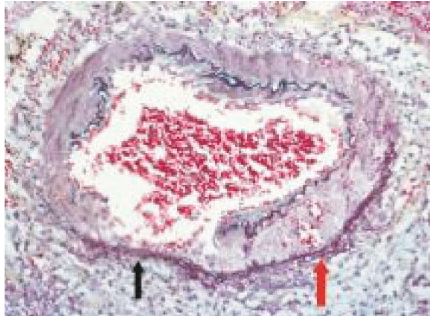
Figure 12: Segmental arterial mediolysis injurious phase. The black arrow points to an arterial gap lined by a linear adventitial fi brin deposit. The adjacent arterial wall at the red arrow shows total medial replacement with granulation tissue consisting of a few dilated capillaries in expanded extracellular matrix material. The internal elastica here is preserved. Movat stain × 50 (adapted with permission from the American Journal of Surgical Pathology 13(7) copyright l989, Lippincott, Williams and Williams).